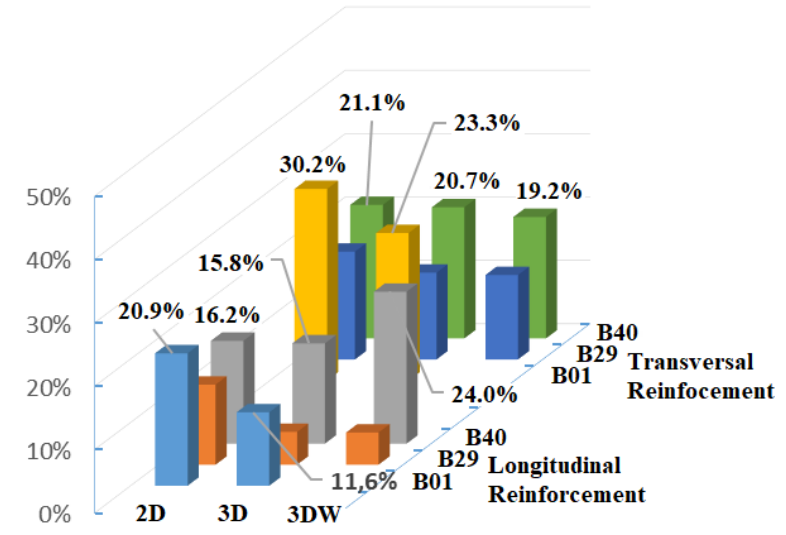
Figure 19. Difference between design results for eccentric and non-eccentric